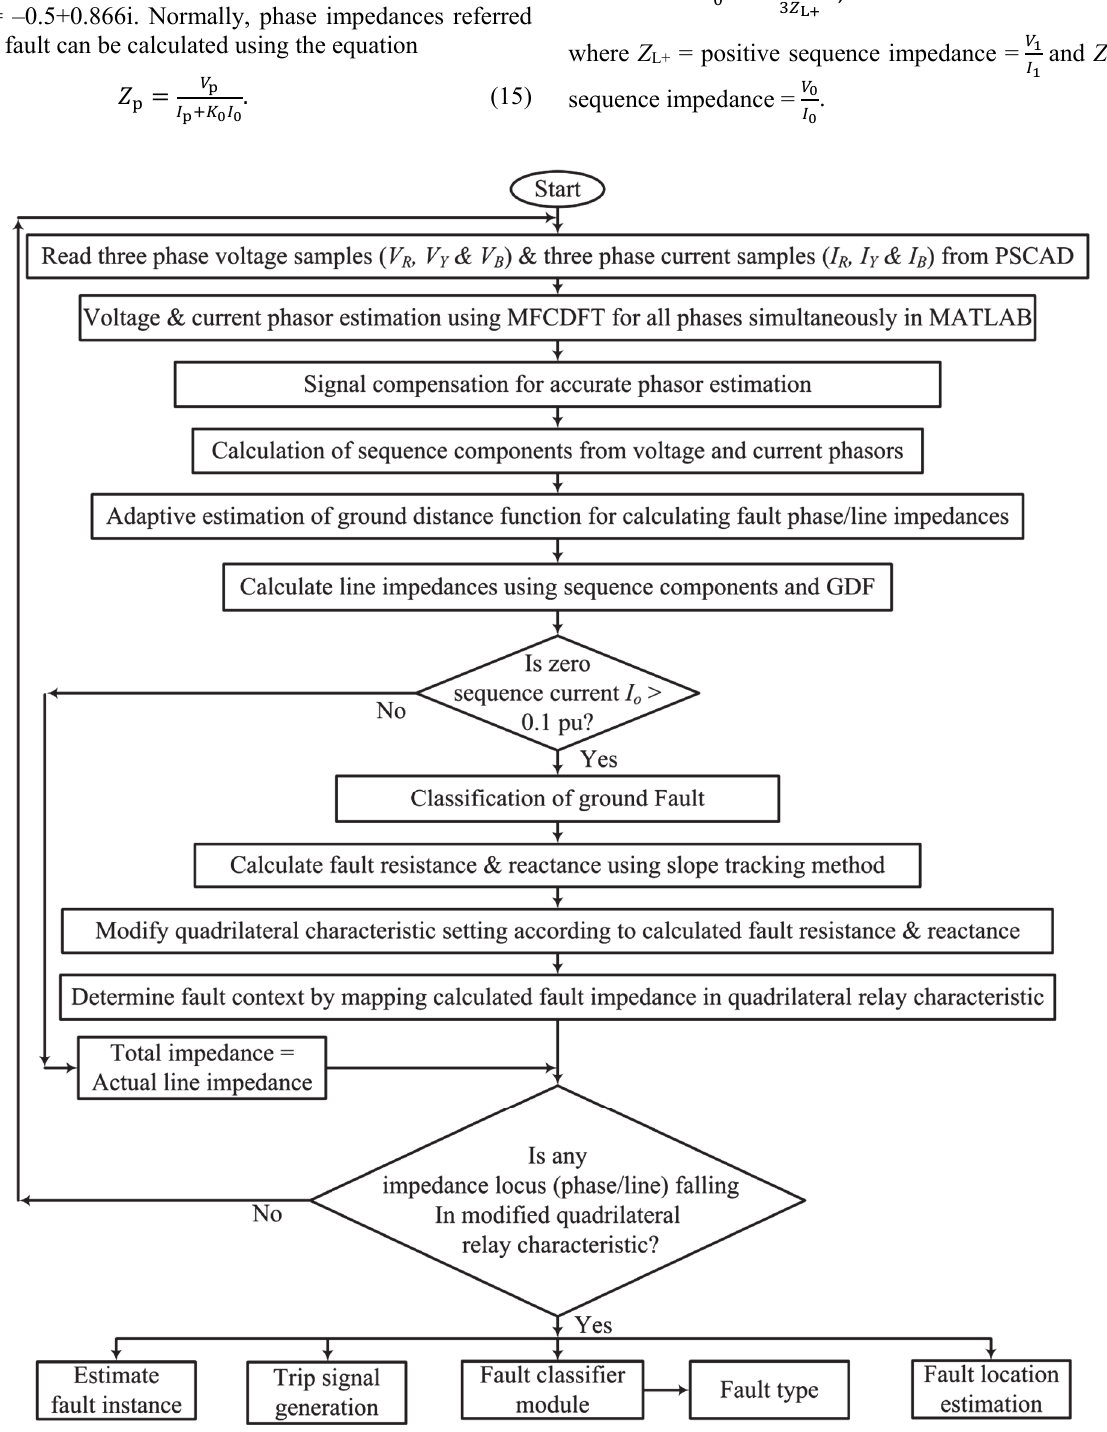
Fig. 4. Proposed methodology for transmission line